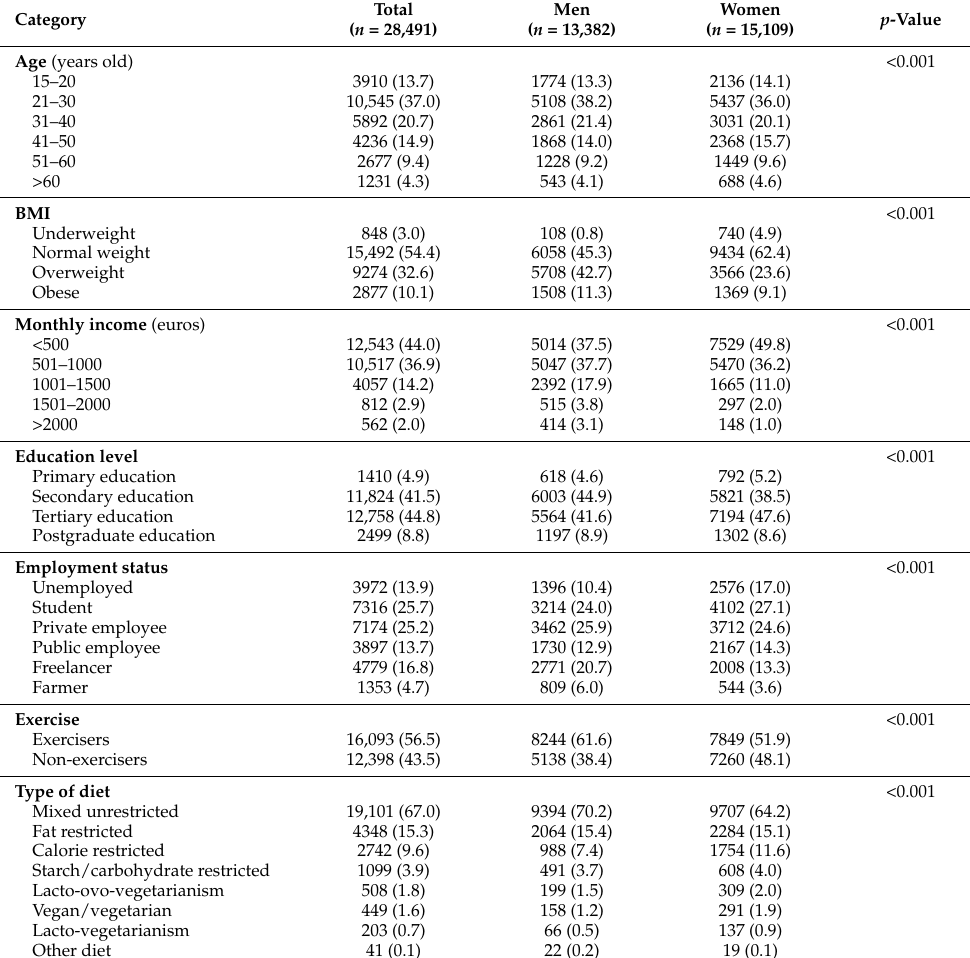
Table 1. Absolute and relative frequencies in parenthesis (%) of personal and demographic character- istics overall (total) and according to sex. The p -values of chi-square tests are presented.